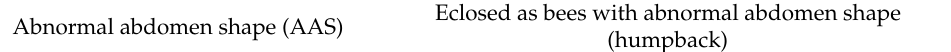
Table 2. List and descriptions of mortality symptoms during developmental stage and deformation symptoms observed in emerged adult bees. This table is modified from Fine et al. [42] and Barbosa et al. [43]. Symptom Description Early death (ED) Sunk in diet, failed to maintain the C-shape, flattening Death with darkening internally or externally, having Melanizing death (MD) black spots Failure to evert imaginal discs, but the pupal molt is Failed molt (FM) incomplete Failed adult molt (FA) Failure to emerge from final molt Surviving normal (SN) Survived and successfully eclosed as bees Deformed wings (DW) Eclosed as bees with deformed wings -with short wings (DSW) Eclosed as bees with short wings -with tangled wings (DTW) Eclosed as bees with tangled wings Deformed antennae (DA) Eclosed as bees with deformed antennae Eclosed as bees with abnormal abdomen shape Abnormal abdomen shape (AAS)